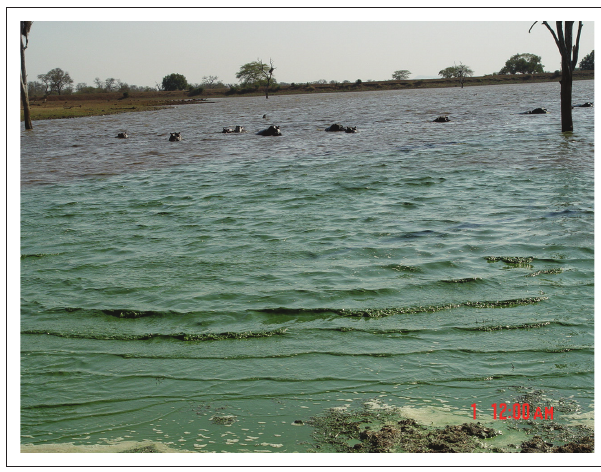
Source : Photo taken by R.G. Bengis FIGURE 11: Hippopotami and algal bloom at Shilolweni